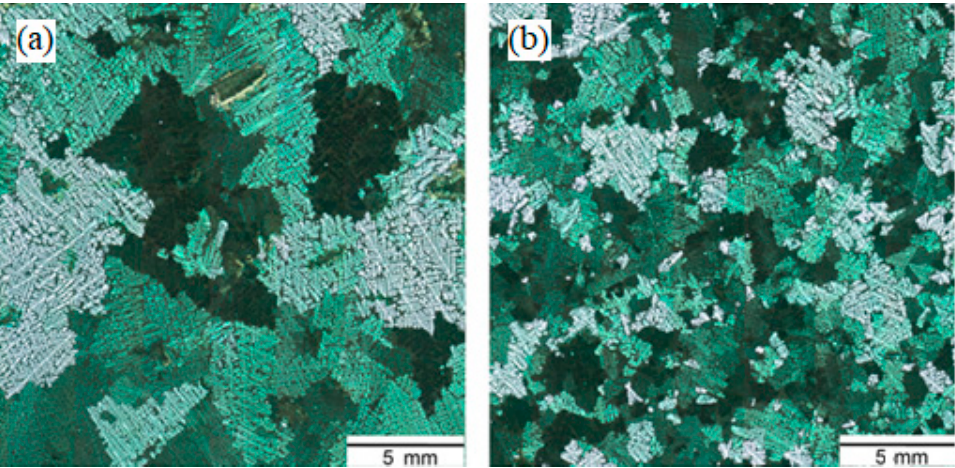
Figure 11. Macrostructure of the test samples: ( a ) without ECP; and ( b ) with ECP [2]. In [4], an alternating electric current pulse (ECP) was generated by a transformer and a silicon rectifier, which provided a frequency from 2 to 1600 Hz and a current amplitude from 0 to 10,000 A. The experiments were carried out at current amplitudes of 0, 300, 400 and 600 A and a pulse frequency of 50 Hz. The Al-7 wt.% Si was treated. The authors, using five thermocouples, recorded the temperature in different parts of the sample and recorded that during pulse processing, a change in the nature of the temperature change in the upper part of the melt (a decrease in the cooling rate) is observed, while for the melt below the level of 68 mm from the bottom of the crucible, the character of the temperature does not change significantly. Consequently, the authors did not observe explicit mixing of the melt under the action of the Lorentz force. However, significant differences were observed in the nature of crystallization of melts using pulsed treatment, namely, in the upper part of all pulsed ingots, a zone of equiaxed grains of a fine equiaxed zone (FEZ) appeared, while in untreated ingots only columnar crystals were observed. In the microstructure (Figure 12a–d), as the pulse current increases, the transformation of coarse dendritic grains into a fine equiaxed cellular structure is observed.